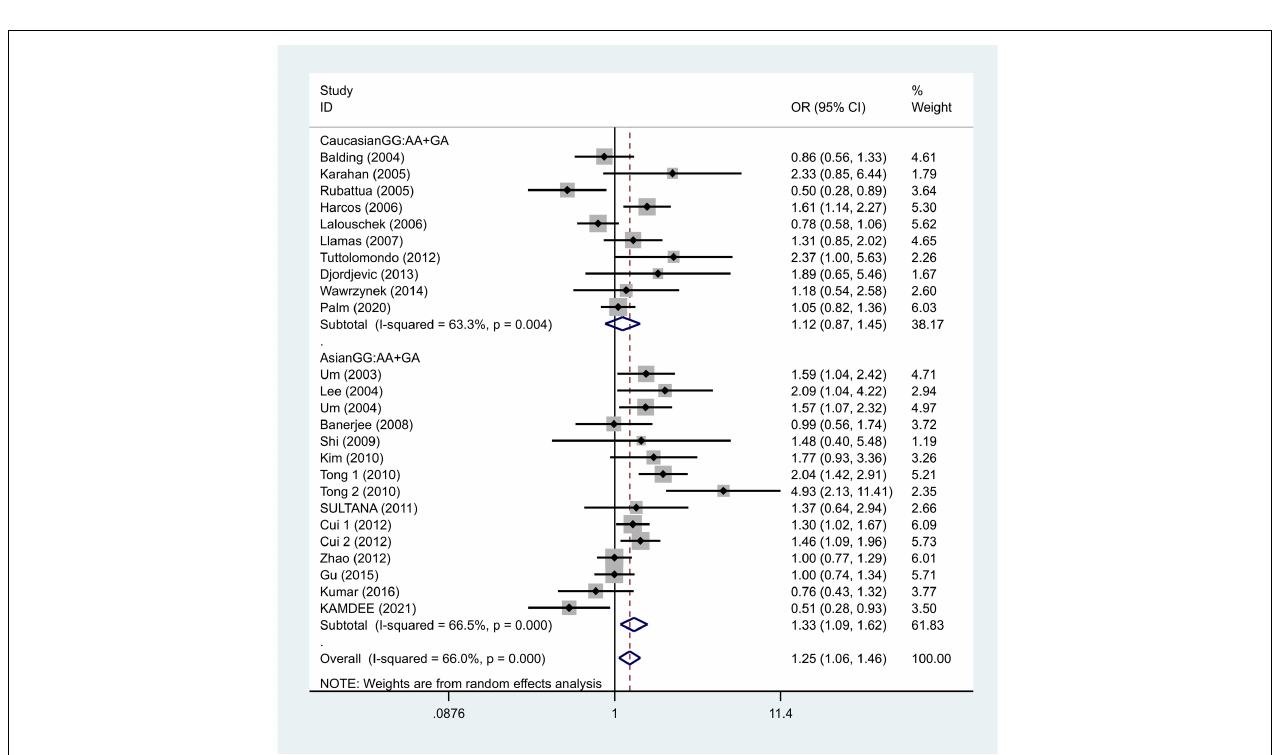
FIGURE 4 | Results of the random-effects meta-analysis for the TNF- α G308A genotype (GG vs. AA + GA) in Caucasian, Asian, IS, and control groups, respectively.